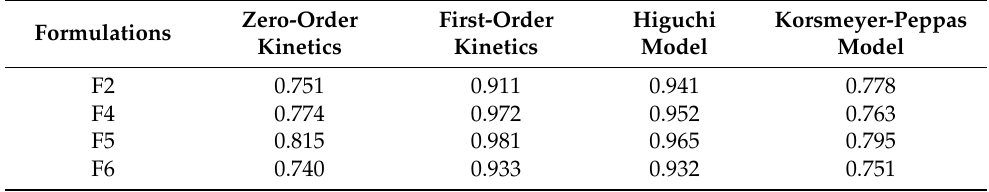
Table 4. Release kinetics of drug from nanoparticle